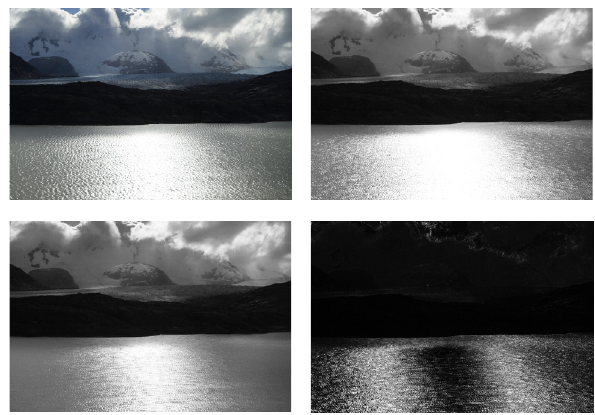
Figure 10. Sunlight reflections on the water surface; max- and min-store image; gray value spread difference between max-/min-store (clockwise from top left).